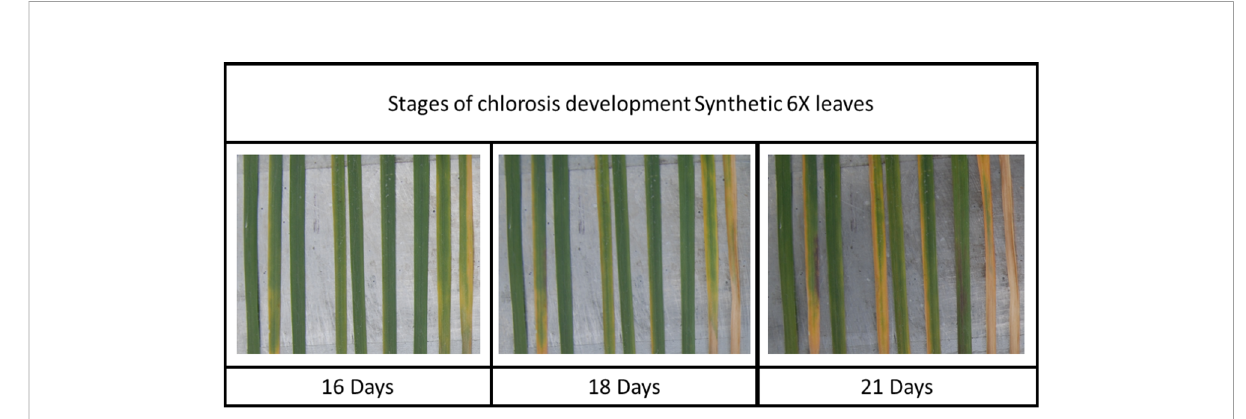
FIGURE 3 The early chlorosis symptoms and lack of fungal pycnidia observed on Synthetic 6X leaves at 28 days post inoculation with three different Z. tritici